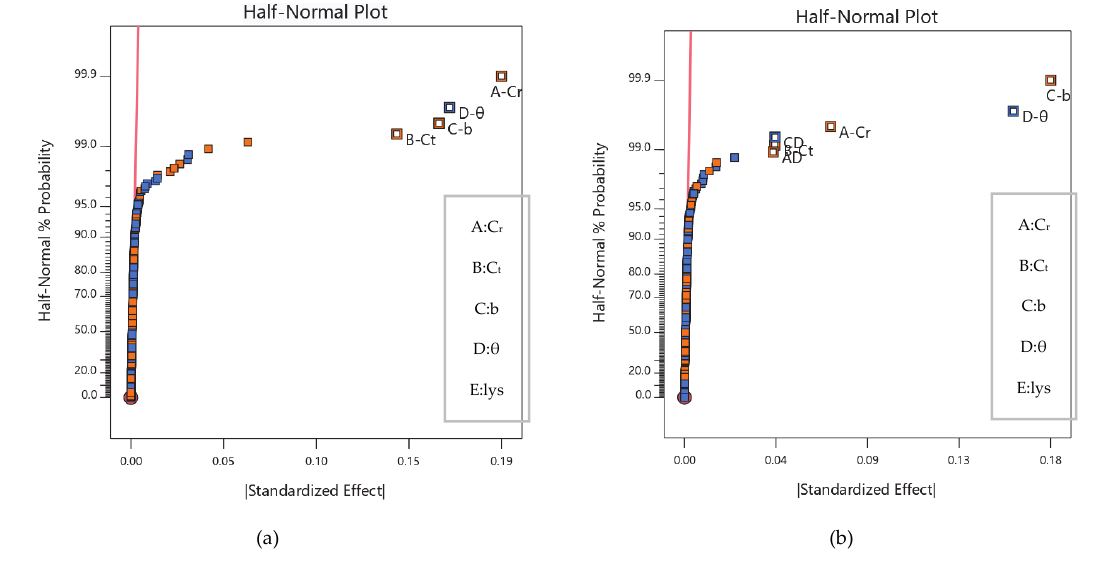
Figure 9. Half-normal distribution of the structural parameters. ( a ) Air resistance half-normal graph; ( b ) time coefficient half-normal graph.